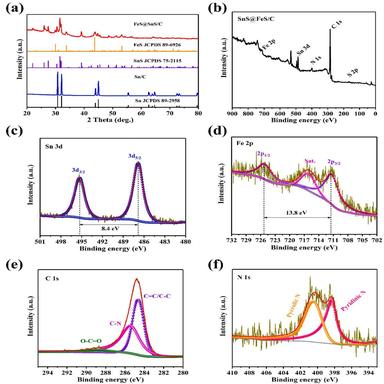
Crystal characterizations. (a) XRD patterns of SnS@FeS/C and Sn/C composites. XPS spectra of SnS@FeS/C composite (b) survey, (c) Sn 3d, (d) Fe 2p, (e) C 1s and (f) N 1s.